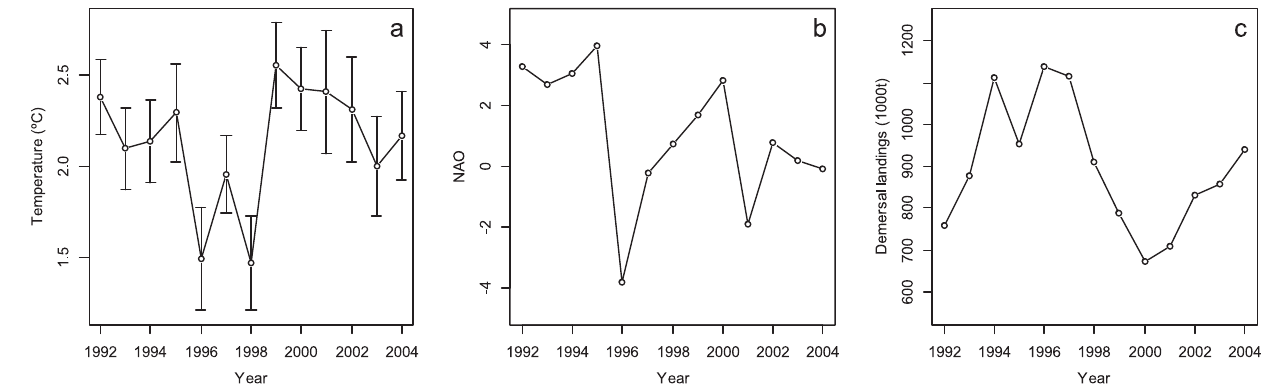
Figure 5. Temperature, NAO index and demersal fish landings. Mean bottom temperature (measured with Scanmar sensor attached to the survey trawl) with 95% confidence interval ( a ), the NAO index from the National Centre of Atmospheric Research, USA [80] ( b ) and demersal fish landings ( Gadus morhua , Melanogrammus aeglefinus , Pollachius virens , Reinhardtius hippoglossoides , Sebastes marinus and Sebastes mentella ) in the Barents Sea (ICES subareas I and II) [81] ( c